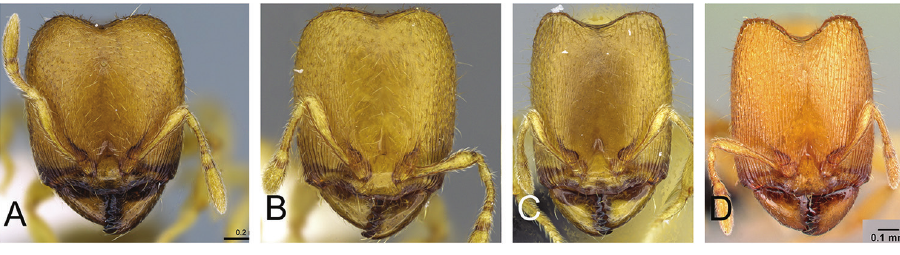
Figure 14. Head in full-face view of A Carebara mahafaly (CASENT0410502) B Carebara salegi (CASENT0438150) C Carebara lova (CASENT0036019) D Carebara kabosy